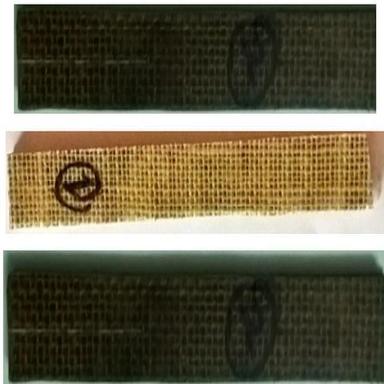
mples for various mechanical testing